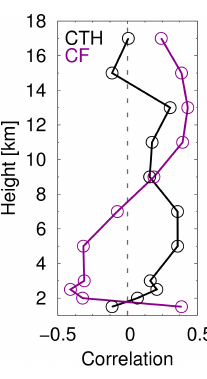
Figure 9. Correlation coefficient of CTH and CF with the El Niño 3.4 index as function of height for the 17years of the GSG data set. Region considered: central East Pacific (170–120 ◦ W, 5 ◦ N–5 ◦